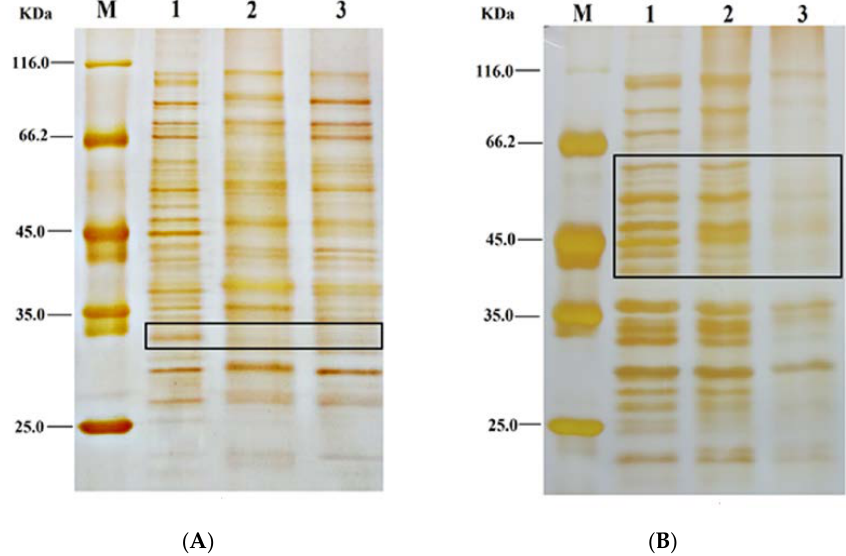
Figure 5. SDS-PAGE of whole proteins. (A): E. coil , Lane-1: protein marker; Lane-2: untreated control; Lane-3: MIC treatment and Lane-4: 2MIC treatment; (B): S. aureus , Lane-1: protein marker; Lane-2: untreated control; Lane-3: MIC treatment and Lane-4: 2 MIC treatment.